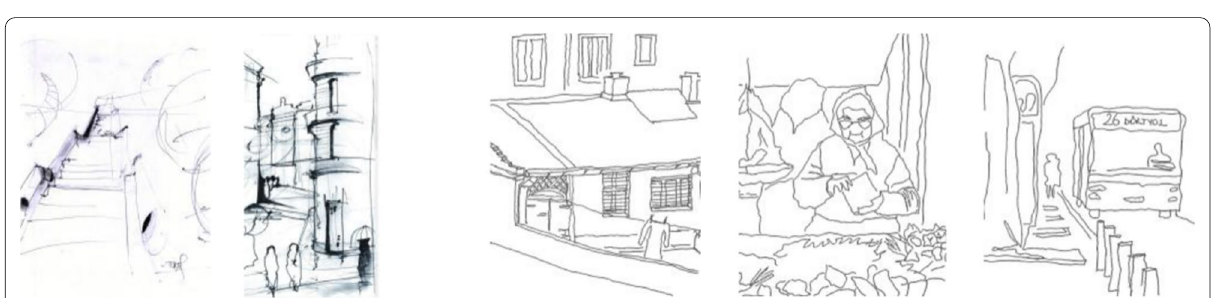
Fig. 11 Experience of urban relations in Kosančićev venac—inhabitant (left) and visitor